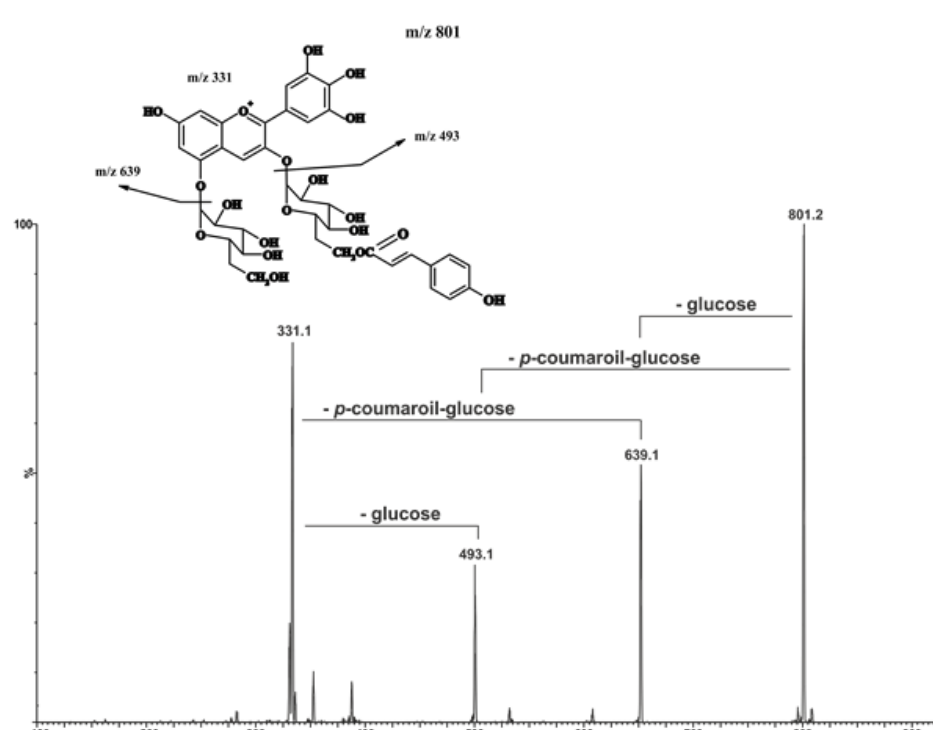
Figure 1. A typical fragmentation pattern mechanism based on the example of malvidine Figure 1 . A typical fragmentation pattern mechanism based on the example of malvidine 3- O -(6 ′ - O - Molecules 2020 , 25 , x FOR PEER REVIEW 3- O -(6 (cid:48) - O -coumaryl)-glucoside-5- O -glucoside. coumaryl)-glucoside-5- O -glucoside .